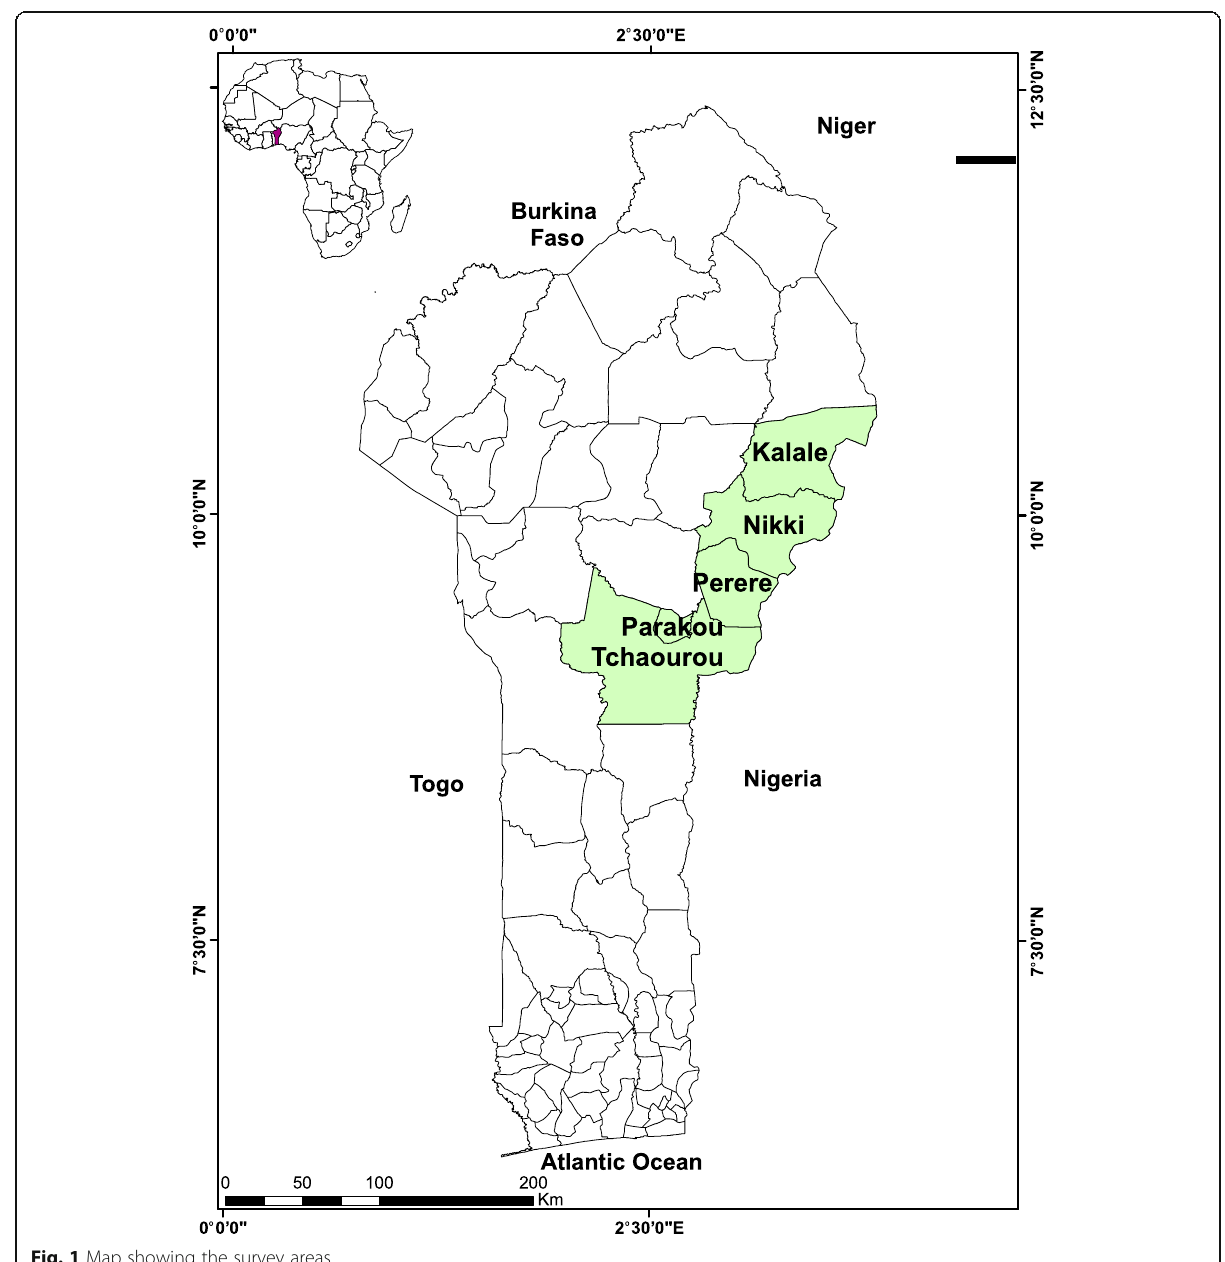
Fig. 1 Map showing the survey